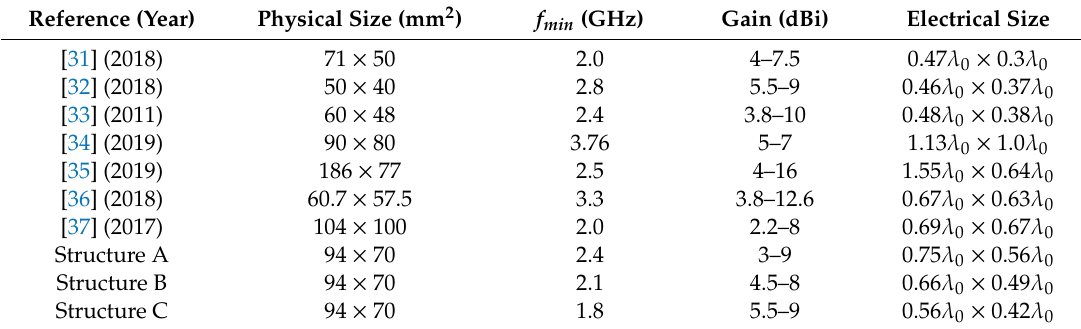
Table 2. Comparison of the similar